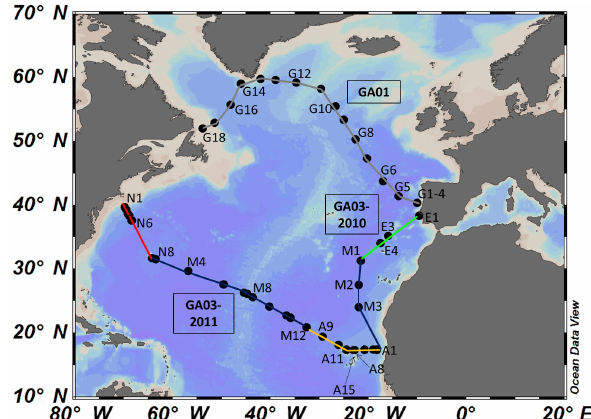
Figure 1. The GEOTRACES GA01 and GA03 cruise tracks (GA01, GA03-2010, and GA03-2011). In total, 57 aerosol samples (GA01 n = 18, GA03 n = 39; black dots) were collected. The samples are grouped by aerosol source region (green is European (E1-4), blue is Marine (M1-12), yellow is North African (A1-15), red is North American (N1-8), and grey is High Latitude (G1-18)), identified from air mass back trajectory simulations using the NOAA ARL model, HYSPLIT (Stein et al., 2015; Rolph, 2017). Note that a dif- ferent labelling convention was used in Shelley et al. (2017) to refer to the GA01 samples. Here we use G1-18 to refer to the samples collected during GA01 (A1-18 in Shelley et al., 2017) and A1-15 to refer to the North African samples from